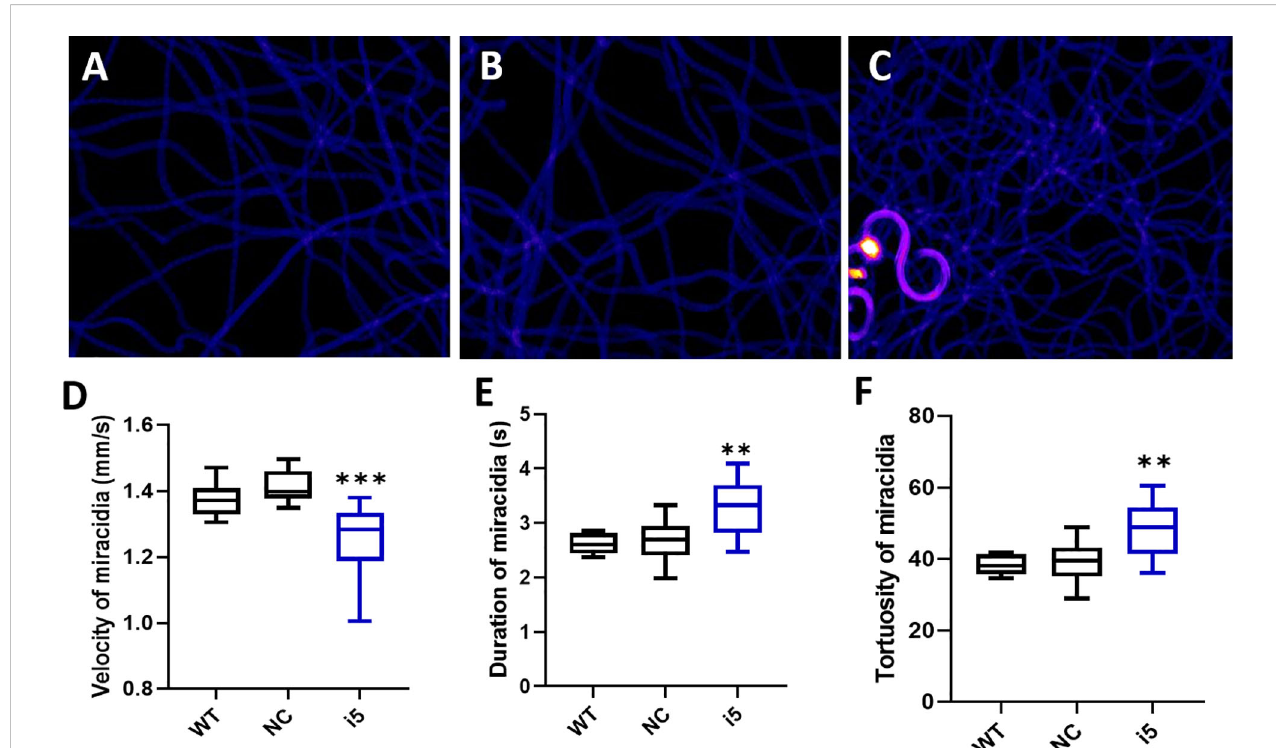
FIGURE 5 Behavioral changes in S. mansoni miracidia hatched from SmfgfrA -suppressed eggs. The behavior of miracidia hatched from WT eggs and eggs treated with NC or i5 was monitored. Heatmaps (A – C) represent the movement patterns of individual miracidia within a 1 min recording. Colors in the heatmaps show the time miracidia spent at a speci fi c position. Black: absence; Blue: shorter time presence; Yellow and Red: longer time presence. Boxplots showing (D) velocity (E) duration, and (F) tortuosity of miracidial movement. Experiments were performed in biological duplicates and fi ve technical repeats (n=10). ** p value ≤ 0.01, *** p value ≤